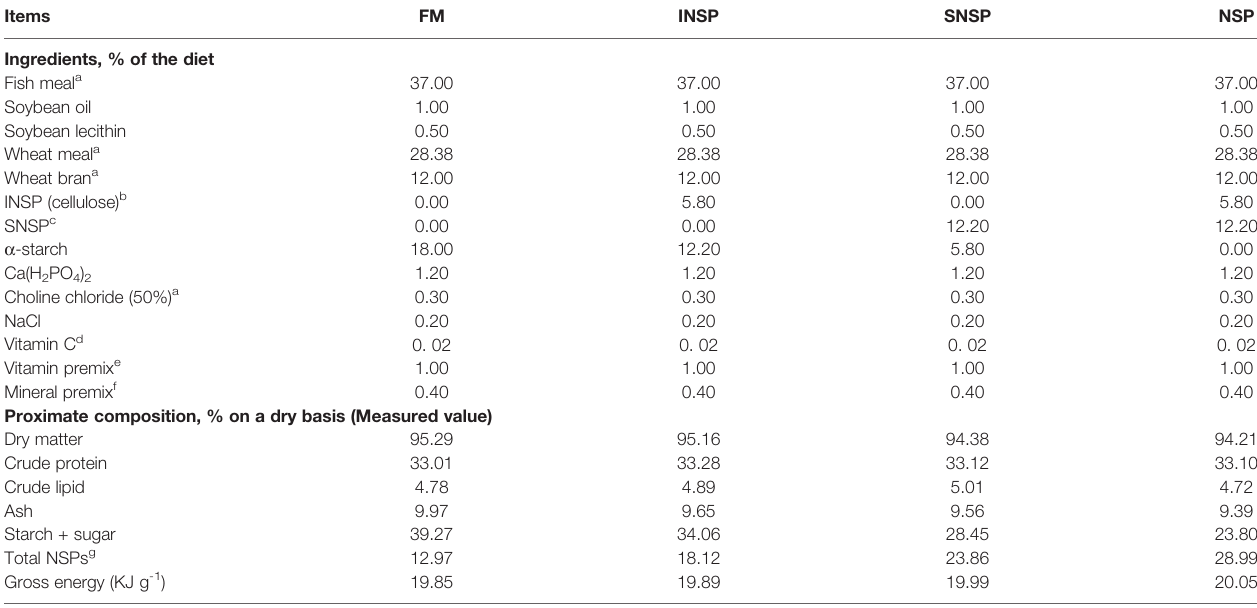
TABLE 1 | Formulation and proximate composition of the experimental diets for GIFT tilapia.